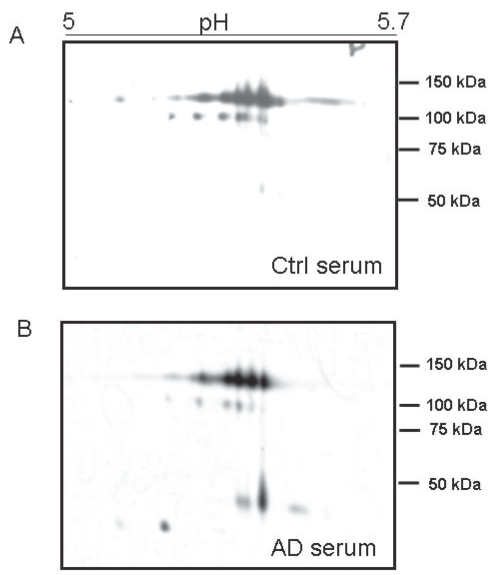
2D analysis of serum ceruloplasmin in AD (A) and control (B). The pH 5–5.7 range is shown. Note how similar is the protein pattern at about 135 and 115 kDa. Low molecular weight (<50 kDa) positive spots are present only in AD serum (B). 450 μl of a 1.5 mg/mL protein solution were loaded per gel. Ceruloplasmin content in both pools was made to 28 mg/dL and each serum sample contributed equally to the ceruloplasmin content.